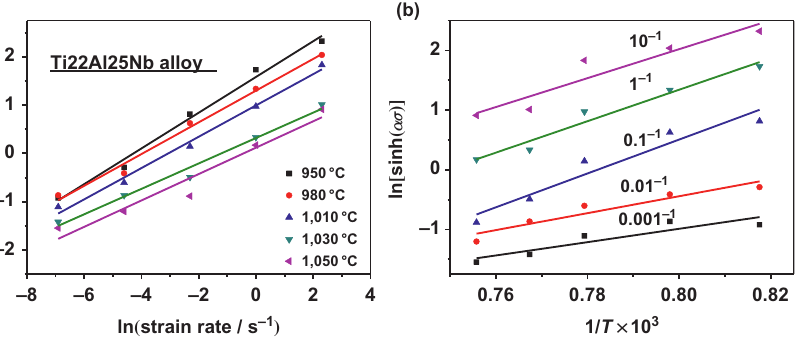
Figure 4: Linear analysis procedure to determine the relationship between peak stress and deformation